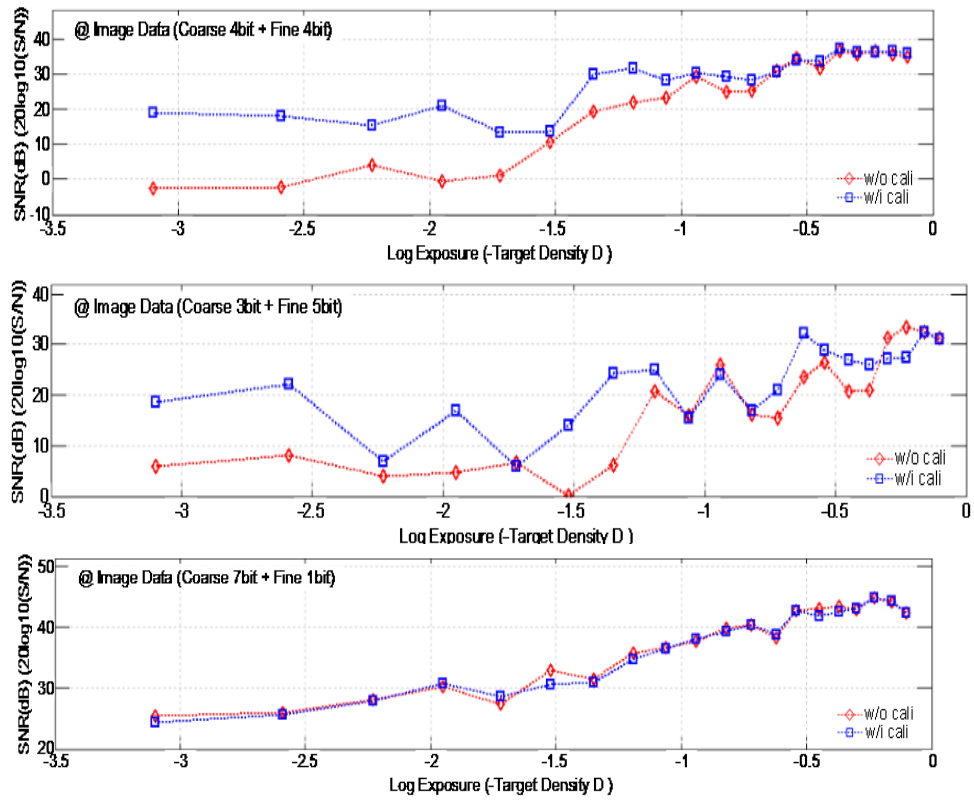
Figure 17. Measured SNR with/without the self-calibration.